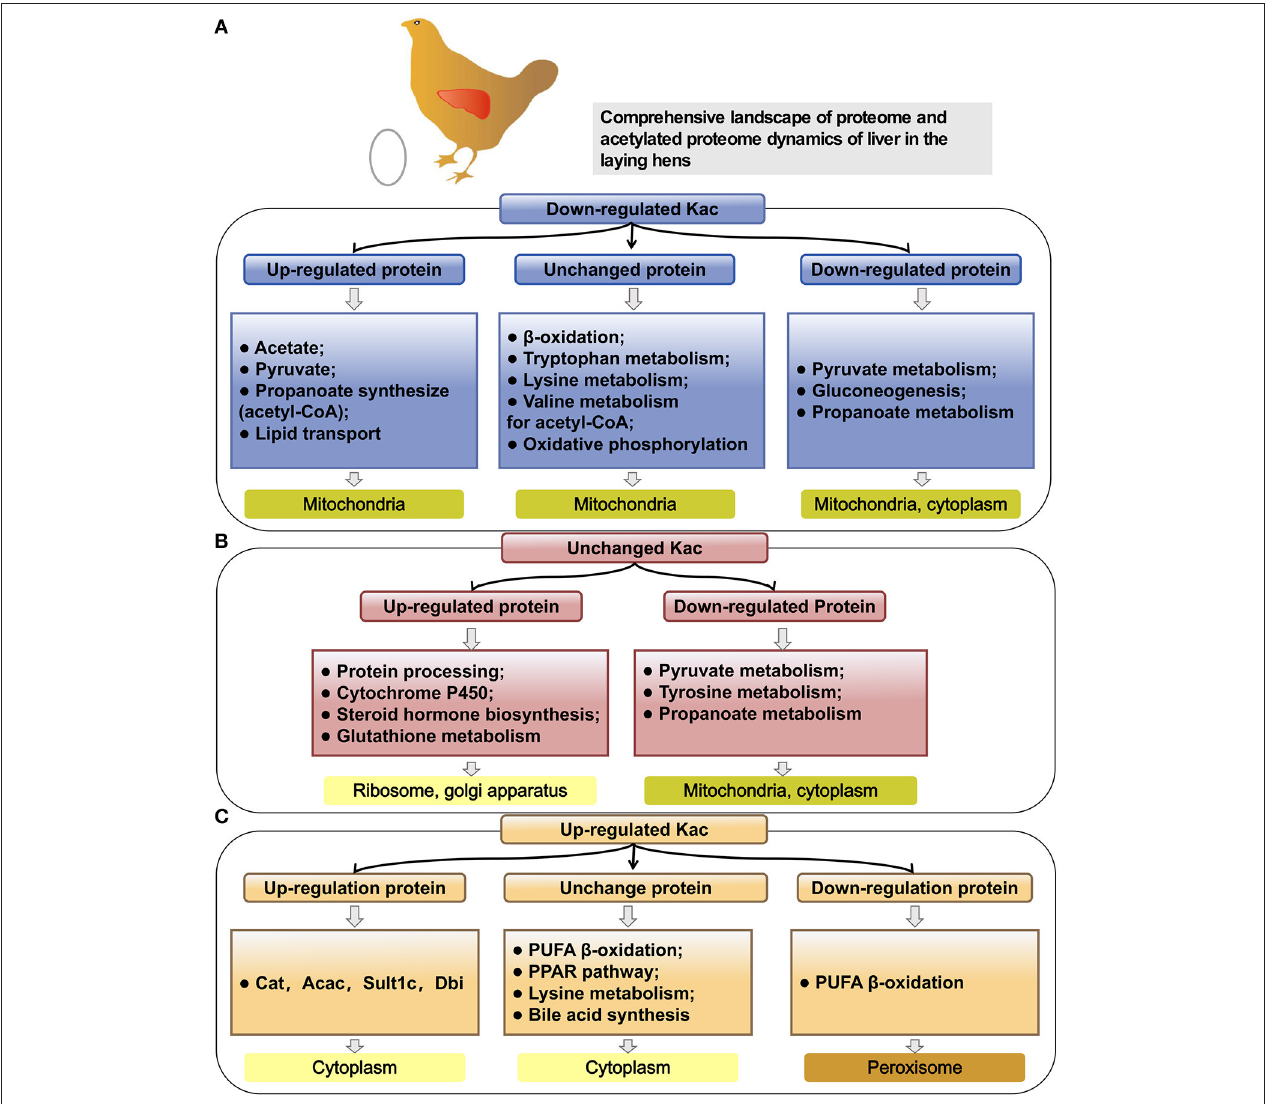
FIGURE 9 | Pathway analysis of different protein groups based on the same background of 1,131 kac proteins. (A) Pathway analysis of PwSDALs with unchanged expression level (104/150), downregulated expression level (12/150) and upregulated expression level (34/150). (B) Pathway analysis of PwSUALs with downregulated expression level (8/40), unchanged expression level (28/40), and upregulated expression level (4/40). (C) Pathway analysis of two groups based on the differences of their acetylation levels in livers between pre- and peak-laying hens, including upregulated proteins (58/782) and downregulated proteins